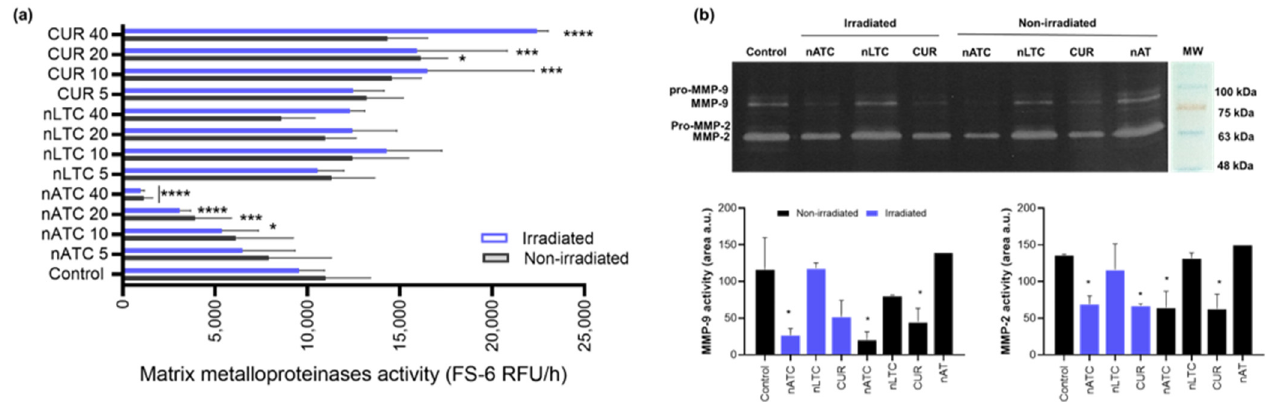
Figure 8. Effect of PDT on matrix metalloproteinases (MMP). MMP activity was measured on A549 cell supernatants 24 h after incubation with nATC, nLTC, and free CUR irradiated (fluence of 9 J/cm 2 ) or kept in the dark (non-irradiated). MMP activity was determined using ( a ) the fluorogenic peptide FS-6 for general MMP activity. Statistical significance compared to non-irradiated control was determined using a one-way ANOVA followed by Dunnet’s test, * p < 0.05; *** p < 0.001, **** p < 0.0001. ( b ) Gelatin zymography for specific MMP-2 and MMP-9 collagenase activity. Significant differences in gel degradation areas compared to non-irradiated control cells were determined using a one-way ANOVA followed by Dunnet’s test, * p < 0.05.